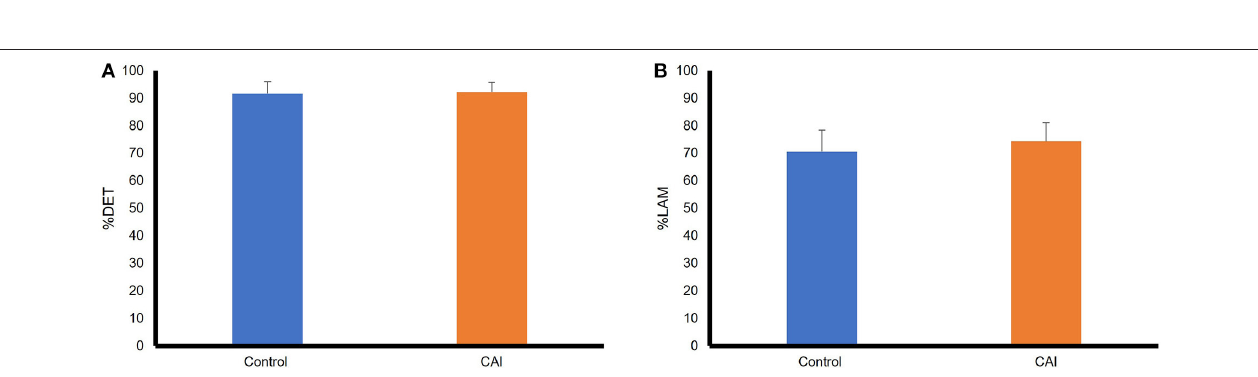
FIGURE 5 | Comparisons of RQA variables between the CAI and control groups in the sagittal plane: (A) A comparison of percent determinism (%DET); (B) A comparison of percent laminarity (%LAM). The error bar represents the standard deviation. RQA, recurrence quantification analysis; CAI, chronic ankle instability.